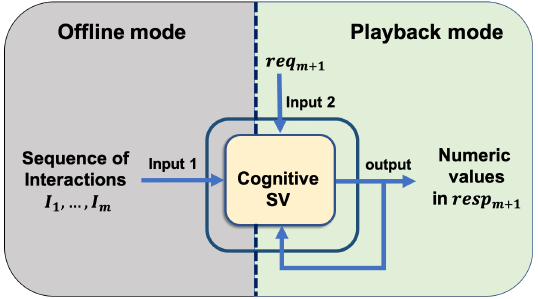
Figure 3. High level overview of CSV with its inputs and outputs.